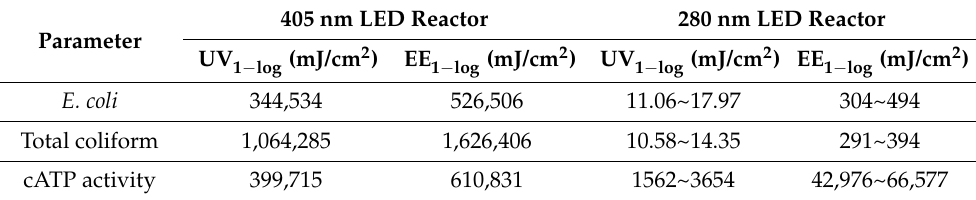
Figure 6. Disinfection of secondary wastewater effluent by the 405 nm LED: ( a ) total coliform log reduction, ( b ) E. coli log reduction, ( c ) cATP log reduction. Table 4. Comparison of the 280 nm and 405 nm LEDs from an energy perspective.